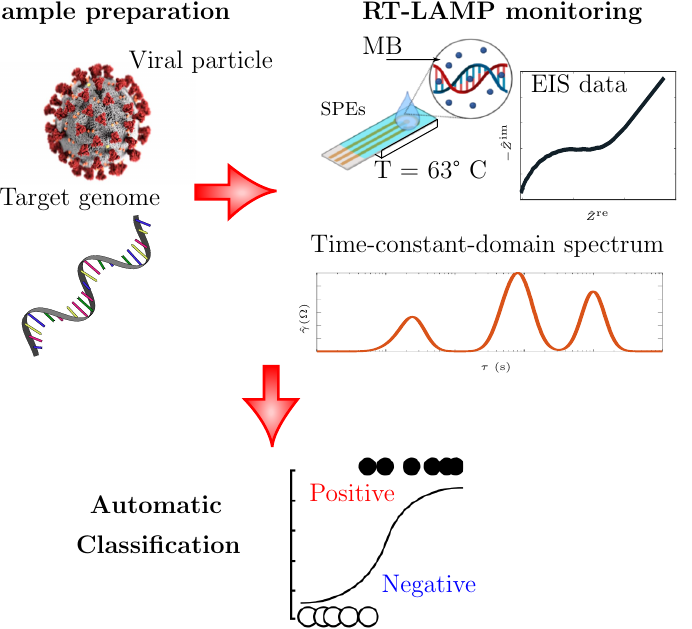
Figure 1. Workflow of the proposed method for analyzing isothermal amplification using electrical impedance spectroscopy (EIS) measurements and time-constant-domain spectroscopy